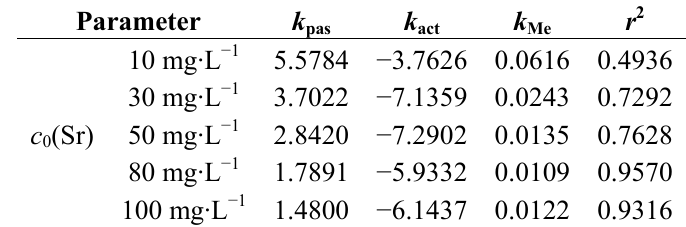
Table 4. The bioaccumulation model